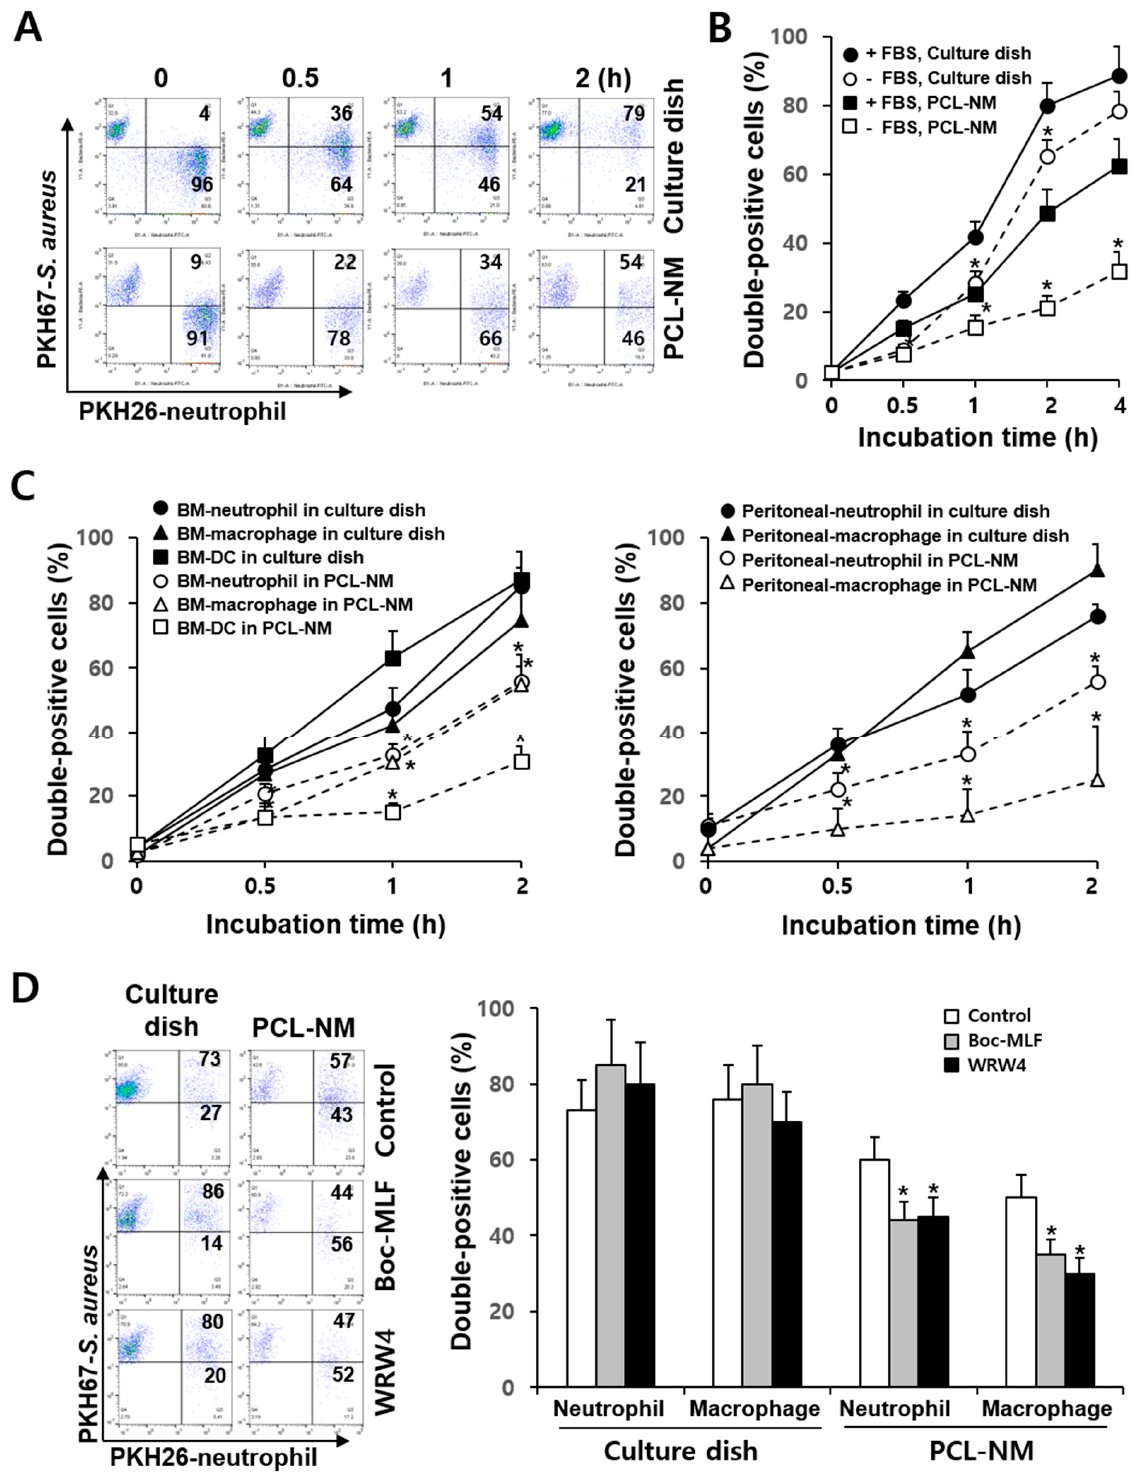
Figure 3. Phagocytosis of S. aureus by neutrophils, macrophages and DCs in the PCL-NM . ( A ) PKH67-labeled S. aureus (1 × 10 6 CFU) was cultured with PKH26-labeled BM-derived neutrophils (1 × 10 5 ) for the indicated times on a culture dish and in the PCL-NM and double-positive cells among PKH26-positive cells were detected by flow cytometry ( n = 4). Numbers represent the percentages of cells within the indicated gates of PKH26-labeled neutrophils. ( B ) BM-derived neutrophils were stained with PKH26 and cultured with PKH67-labeled S. aureus (1 × 10 6 CFU) in the presence (+FBS) or absence ( − FBS) of 5% FBS for the indicated times on a culture dish and in the PCL-NM. Rates of phagocytosis were evaluated by counting double-positive cells among PKH26-labeled phagocytes. Data are presented as means ± SDs ( n = 3). Asterisks (*) denote significant differences compared to culture with FBS ( p < 0.05). ( C ) BM- and peritoneal-derived phagocytes were